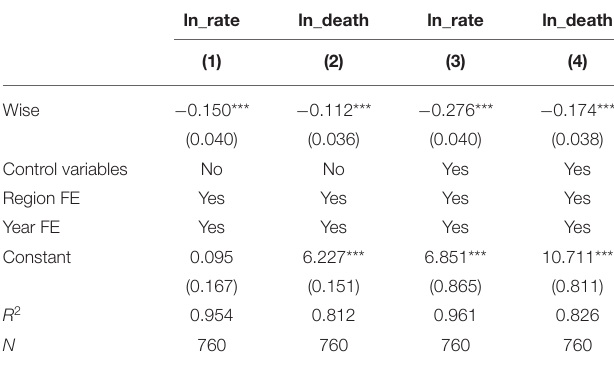
TABLE 7 | Results of controlling other policy effects. TABLE 8 | Results of controlling the individual characteristics of officials.